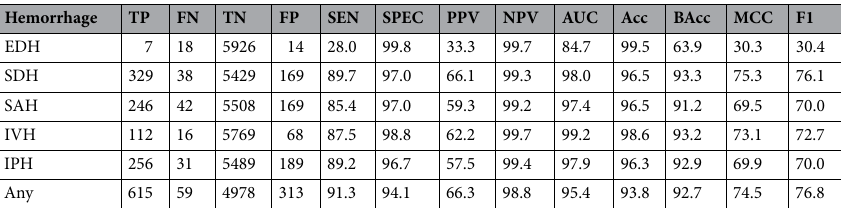
Table 3. ML performance in detecting ICH on the external validation set. TP true positive, FN false negative, TN true negative, FP false positive, SEN sensitivity, SPEC specificity, PPV positive predictive value, NPV negative predictive value, AUC area under the receiver operating curve, Acc accuracy, BAcc balanced accuracy, MCC Matthews correlation coefficient, F1 F1 score. All the values except TP, FN, TN, and FP are in percent.